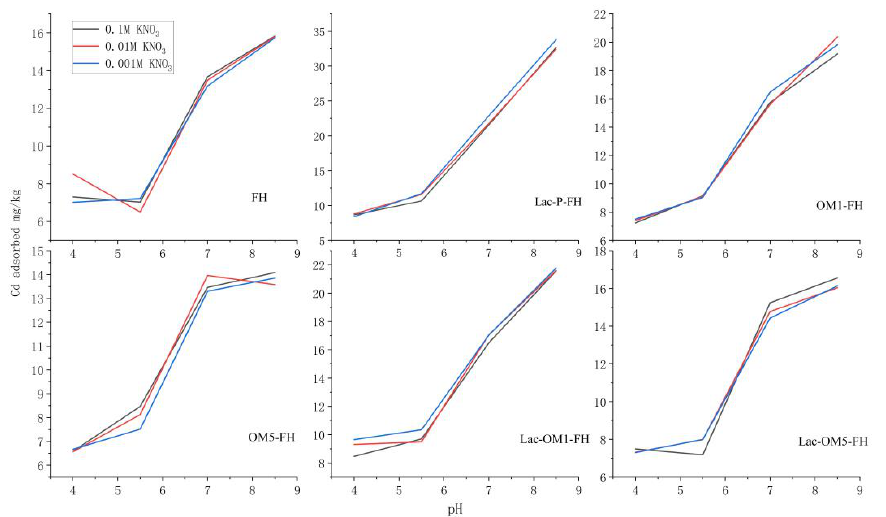
Figure 4. Adsorption edge patterns of Cd onto ferrihydrite (FH) and five iron – organic matter associations (Fe-OM).